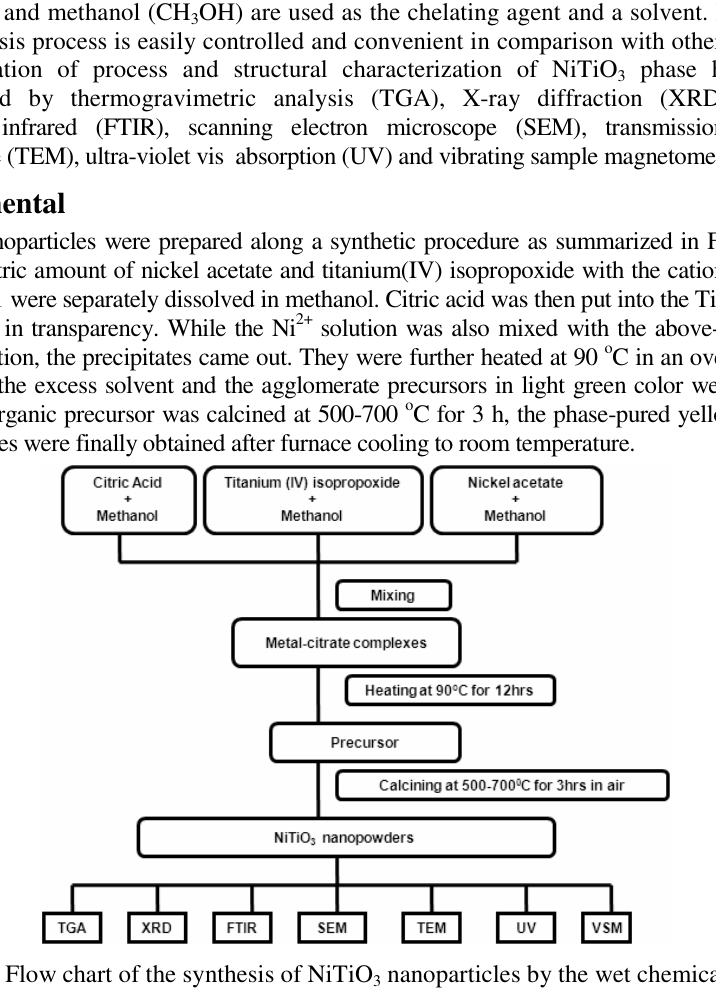
nanoparticles by the wet chemical 3